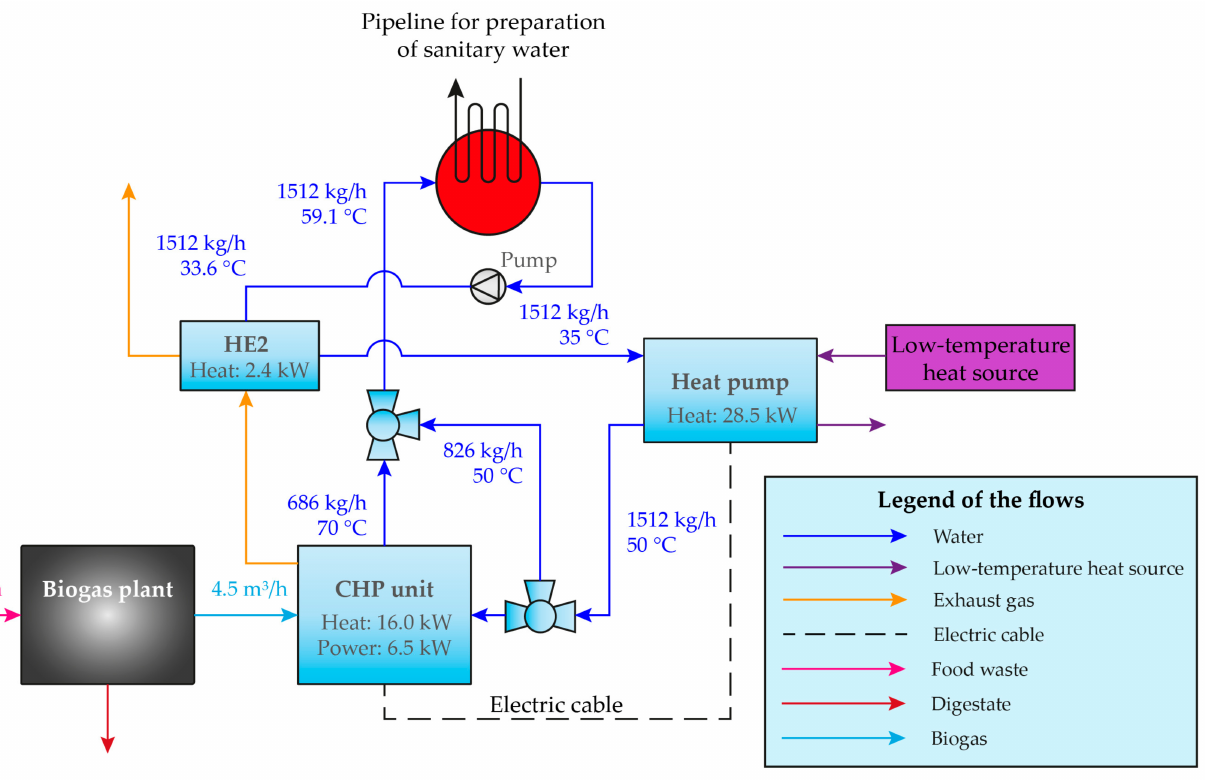
Figure 6. Mass / volume flow rates and temperatures of the innovative design